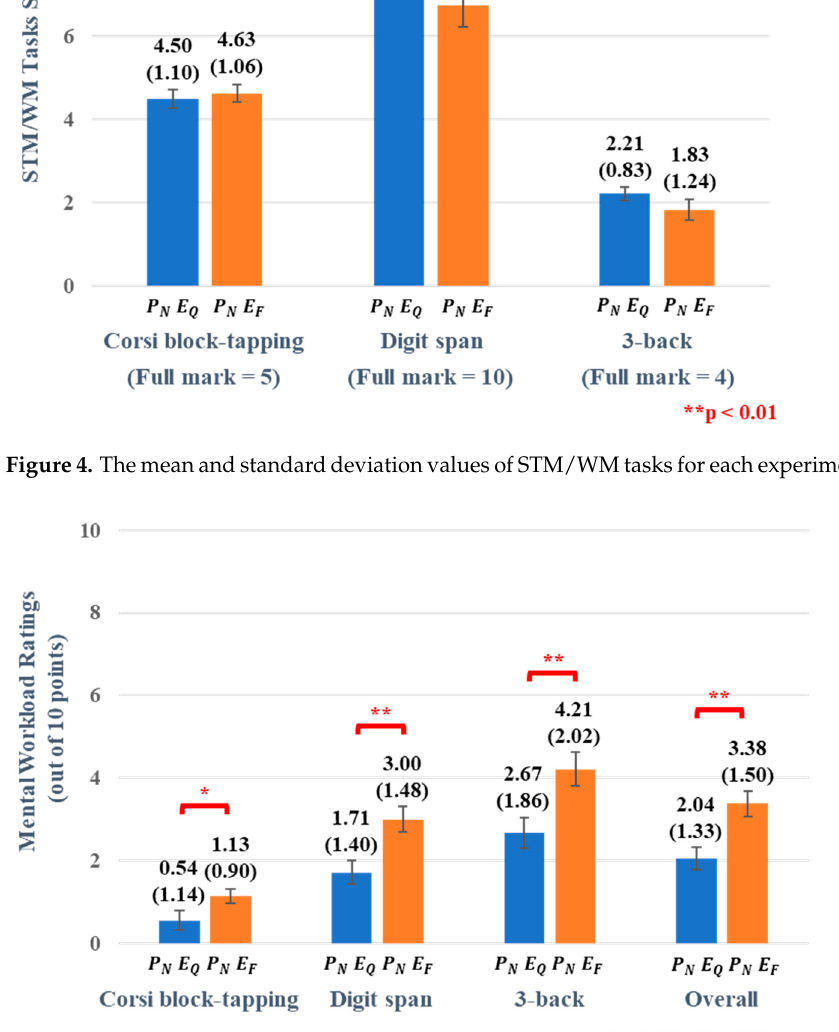
Figure 4. The mean and standard deviation values of STM/WM tasks for each experimental condi- tion.